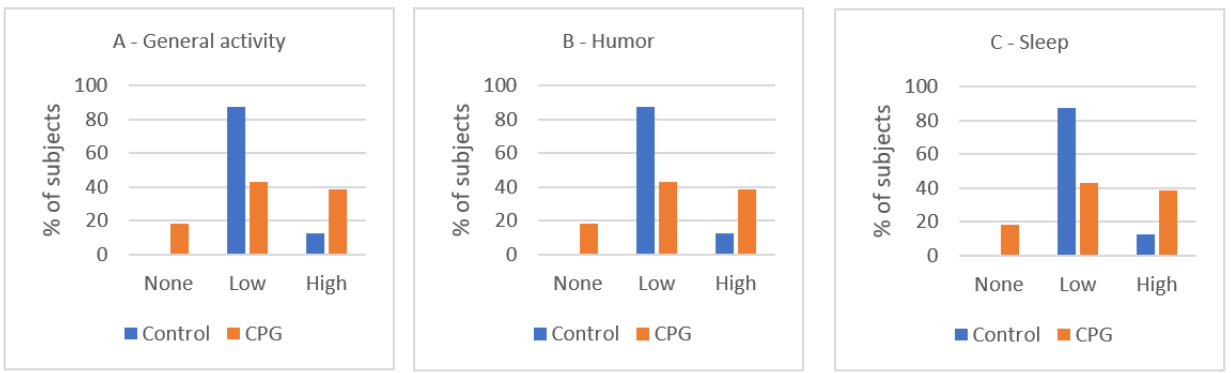
Figure 2. Impact of pain in the control group and CPG (% of subjects per level of interference). ( A ) Level of interference with general activity, ( B ) level of interference with humor, and ( C ) level of interference with sleep. CPG, chronic pain group. Visual inspection of the bar charts indicates a higher interference in the CPG (no statistical differences in Chi ‐ square test).